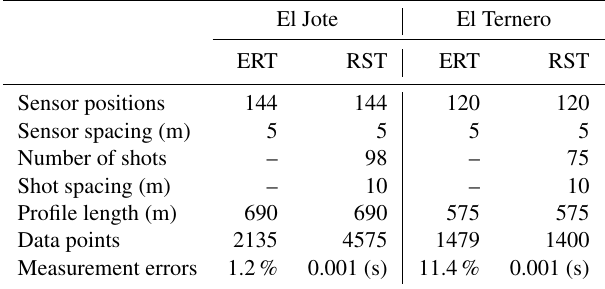
Table 1. Acquisition settings for ERT and RST profiles on El Ternero and El Jote.